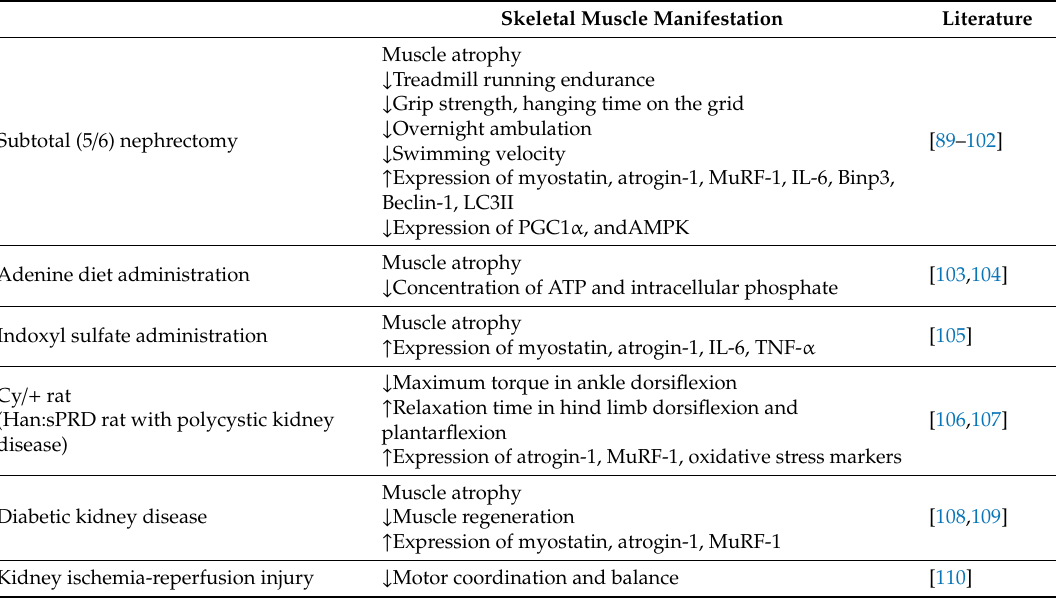
Table 2. Experimental animal models: implication in uremic sarcopenia.